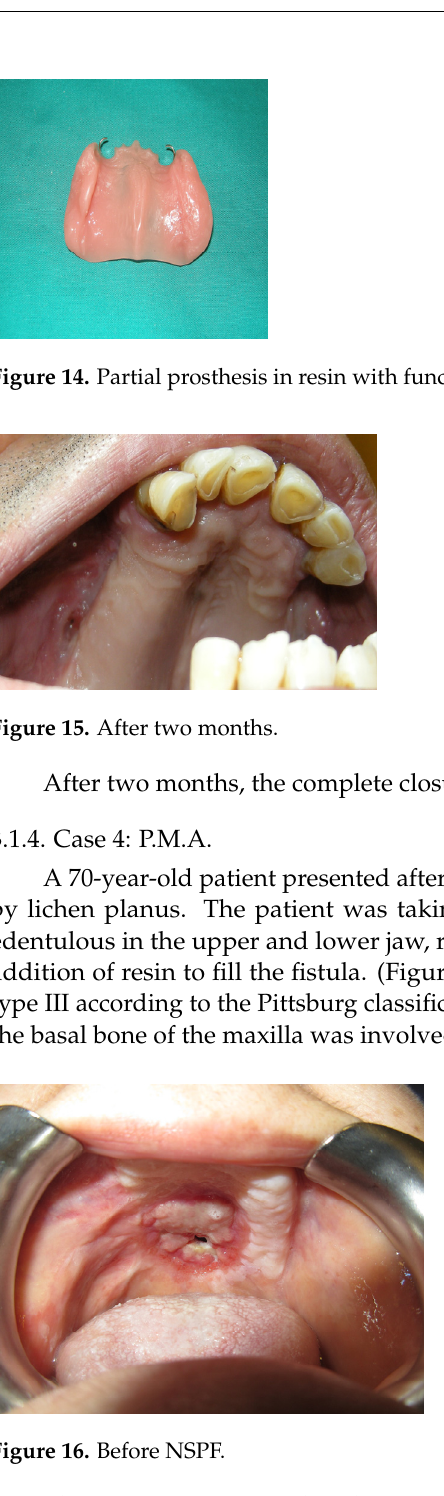
Figure 13. Patient condition at the first visit.